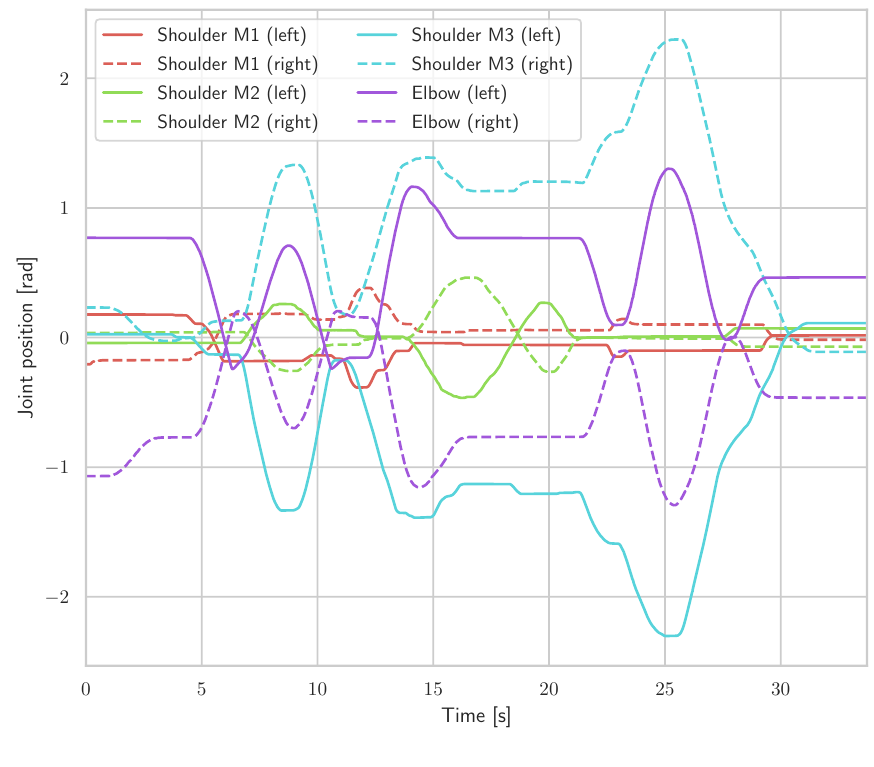
Figure 17. Mirror therapy.